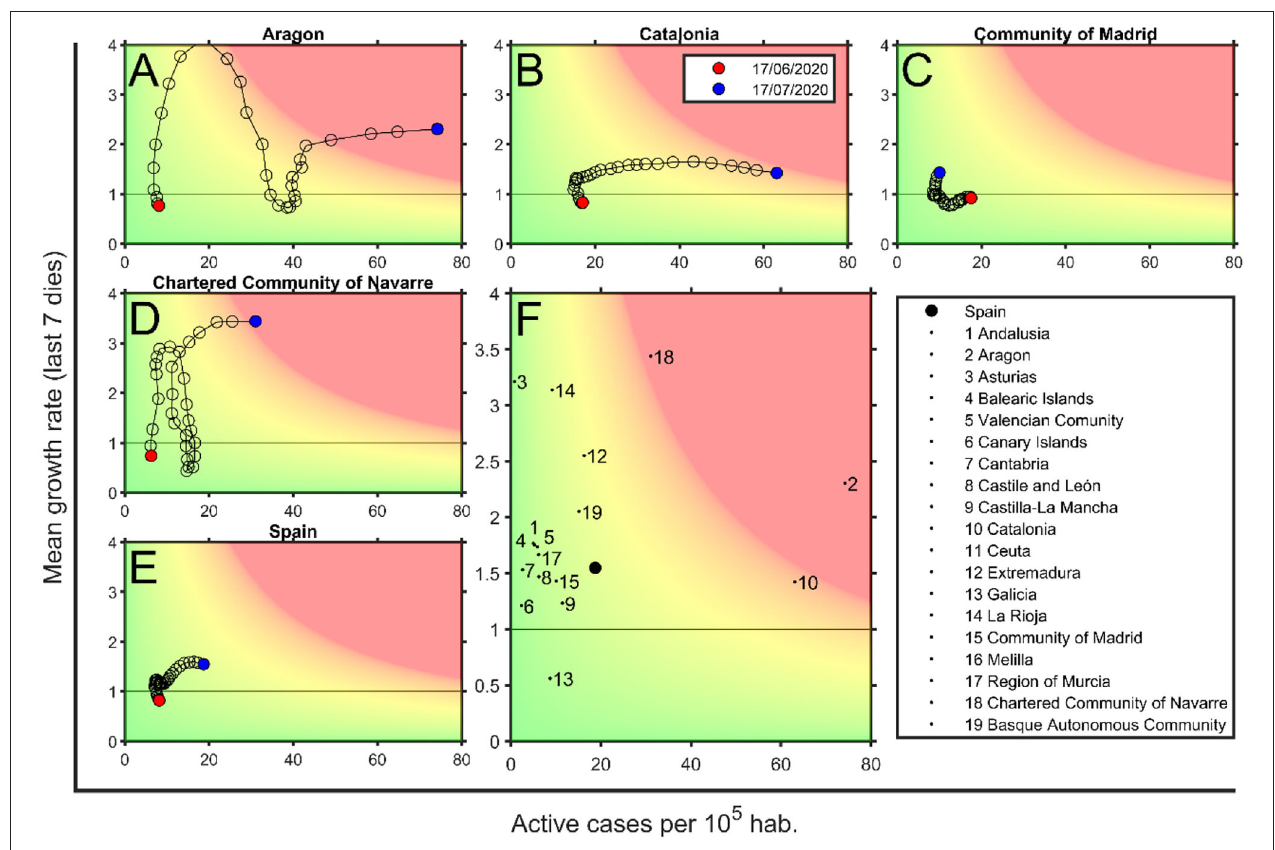
FIGURE 5 | Risk diagrams for Spain and some of its regions on July 17, 2020. (A) Aragon, (B) Catalonia, (C) Community of Madrid, (D) Community of Navarra, and (E) Spain risk diagrams. Each circle corresponds to a day, last day is marked with a black filled circle. (F) Spain region situation, where each dot is the position for each Spanish region on July 17, 2020 (see legend), and filled black circle is the situation of Spain. Background color depends on the Effective Potential Growth (EPG) risk. Red marks EPG = 100 and green is for EPG = 0; there is a linear degradation between both. Zones with an EPG higher than 100 are also marked in red. Data are obtained from Datadista (27) and Instituto de Salud Carlos III (28) on July 18,